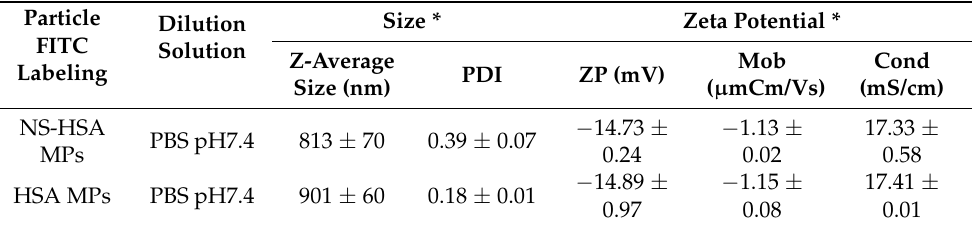
Table 3. Characteristics of hydrodynamic diameter and zeta potential after NS-HSA MPs and HSA MPs labeling with FITC by